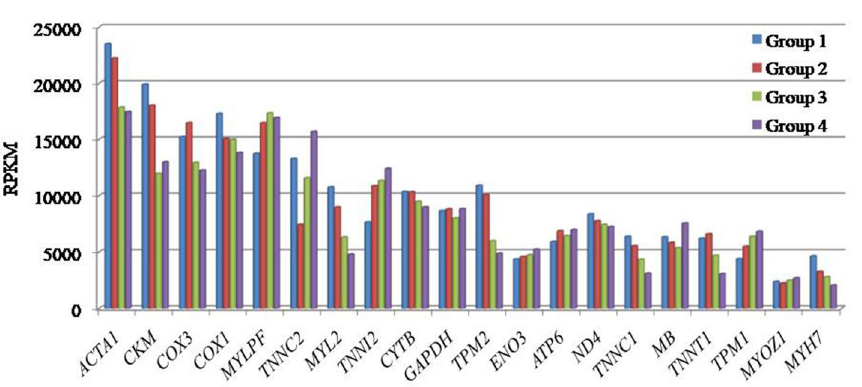
Figure 2. Highest expressed genes with Reads Per Kilobase Million (RPKM) > 2000 across all age groups in Bandur sheep. Group1 = 2 tooth stage or 1 year; Group 2 = 4 tooth stage or 1.5–2 years; Group 3 = 6 tooth stage or 2.5–3 years; Group 4 = 8 tooth stage or 3.5–4